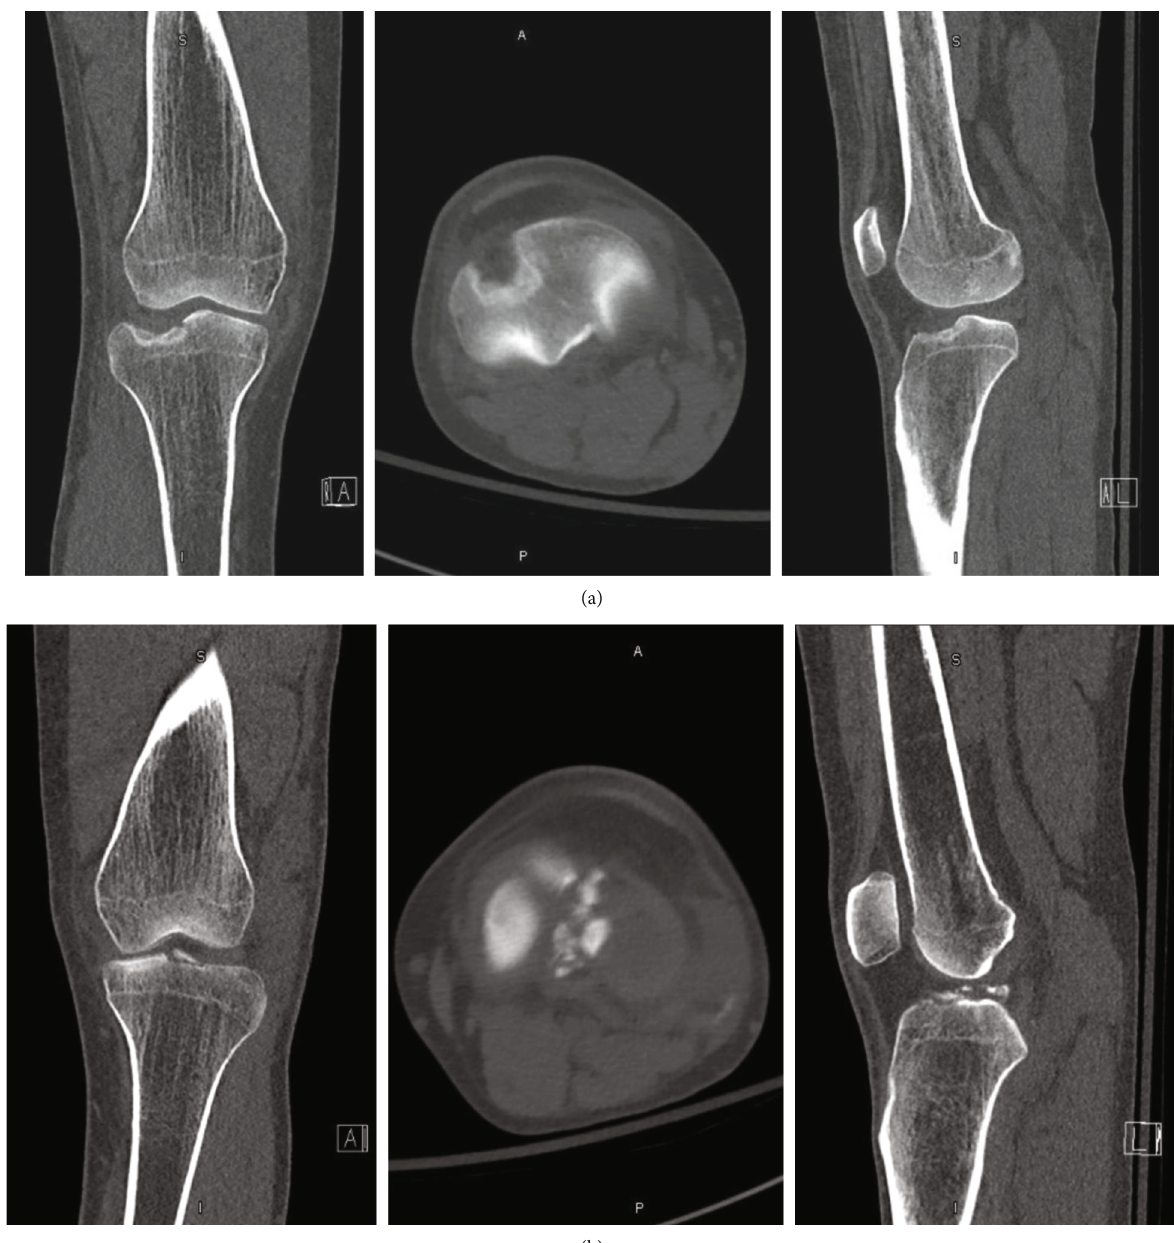
Figure 2: (a) CT scan of the right knee depicting a lateral tibial plateau fracture. (b) CT scan of the left knee depicting a tibial spine